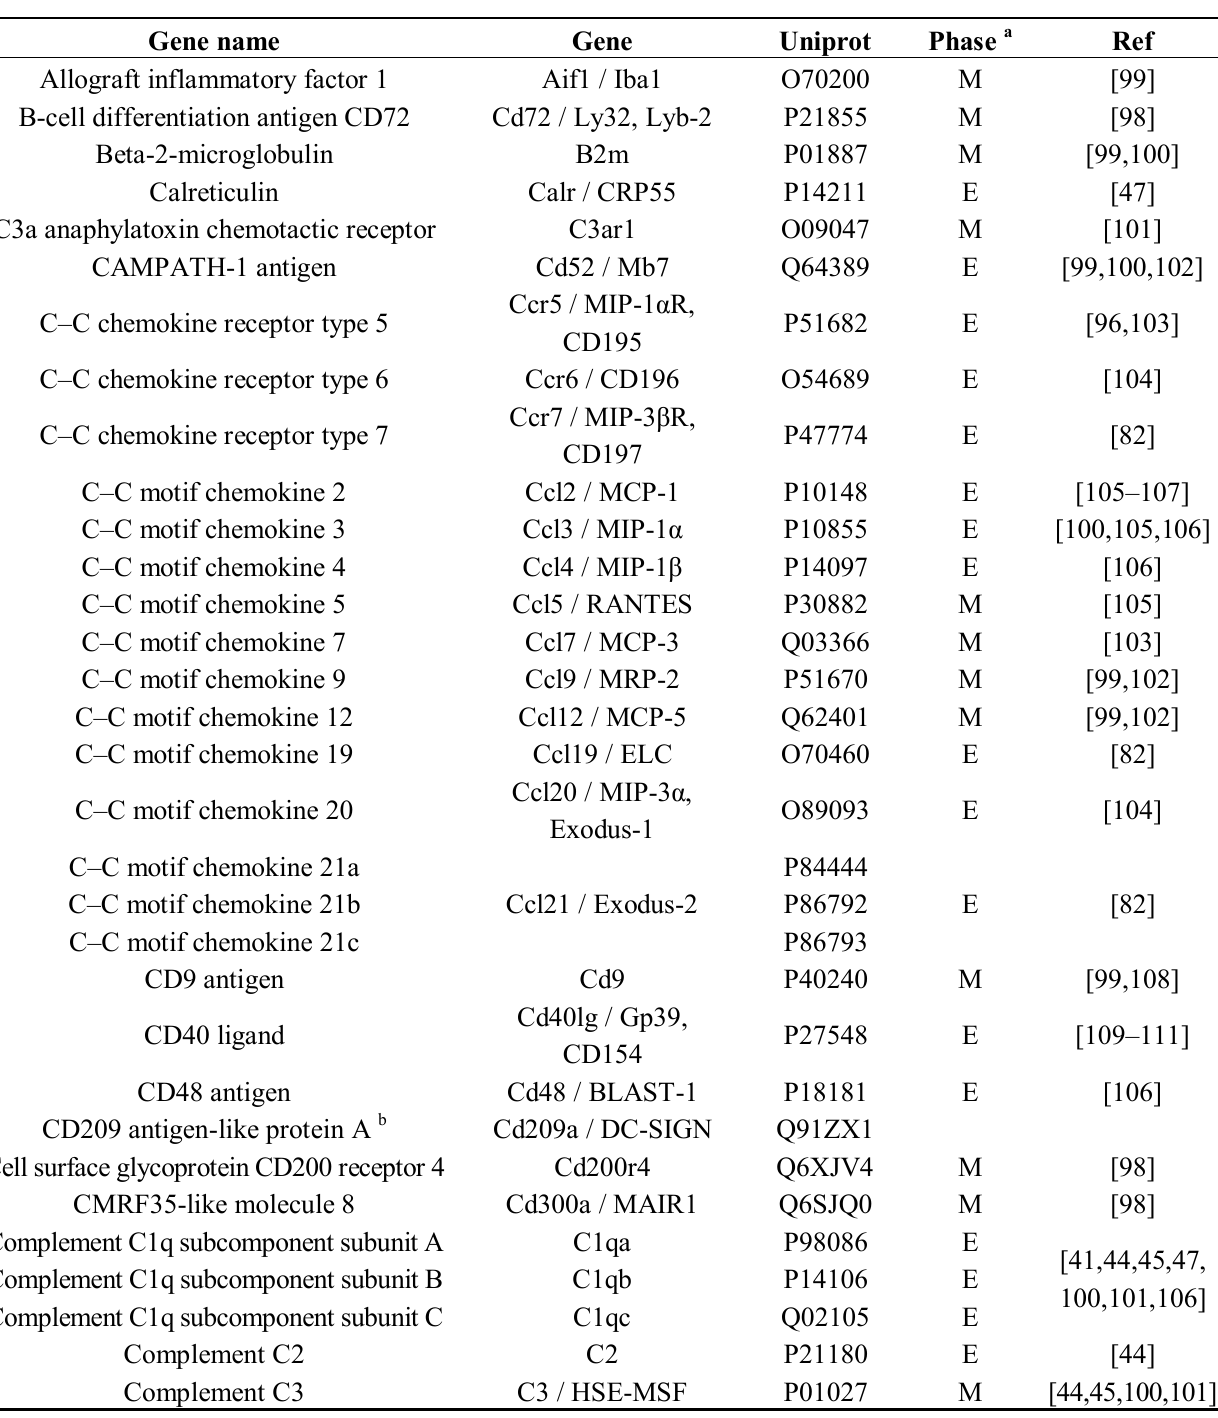
Table 1. Many of the following genes/proteins have been proven or implicated to have a role in the interaction between prion pathogenesis and the innate immune system and are mentioned in this